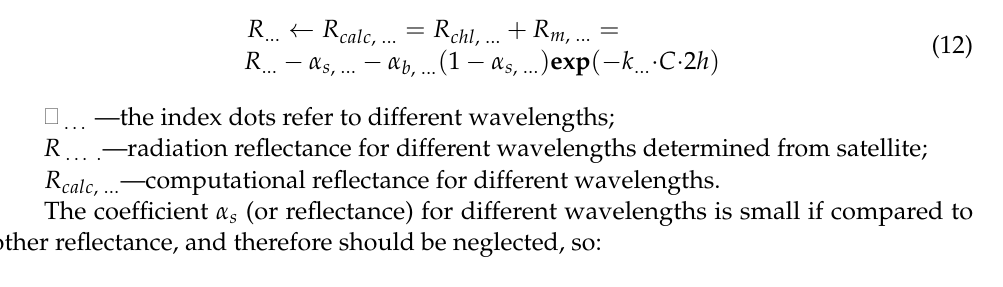
 … —the index dots refer to different wavelengths; R … . —radiation reflectance for different wavelengths determined from satellite; ,... calc